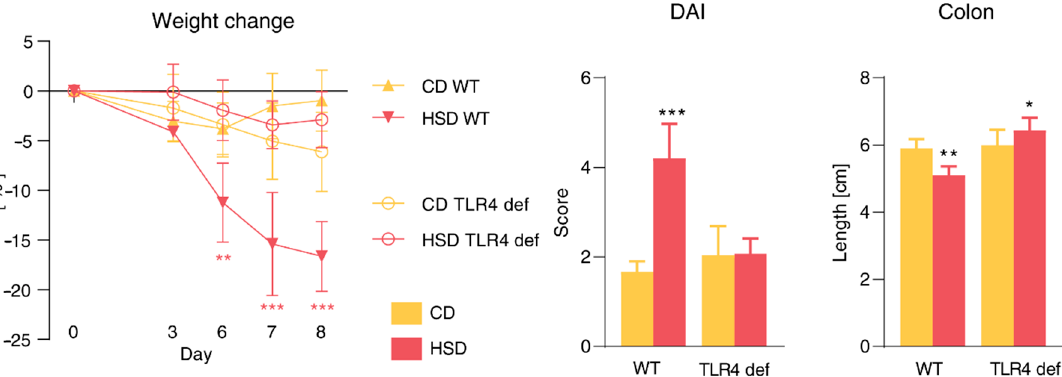
Figure 9. Detrimental effect of HSD is abrogated in TLR4-deficient mice. Weight change, DAI, and colon length. Data presented are from two experiments, n = 5–8 mice per group. The weight change was analyzed by two-way ANOVA with Bonferroni post hoc test and other parameters by unpaired t test in a particular genotype. Data are shown as mean ± SD. * p < 0.05, ** p < 0.01, *** p < 0.001. CD, control diet; HSD, diet rich in simple carbohydrates; WT, wild-type mice; TLR4 def, TLR4-deficient mice.